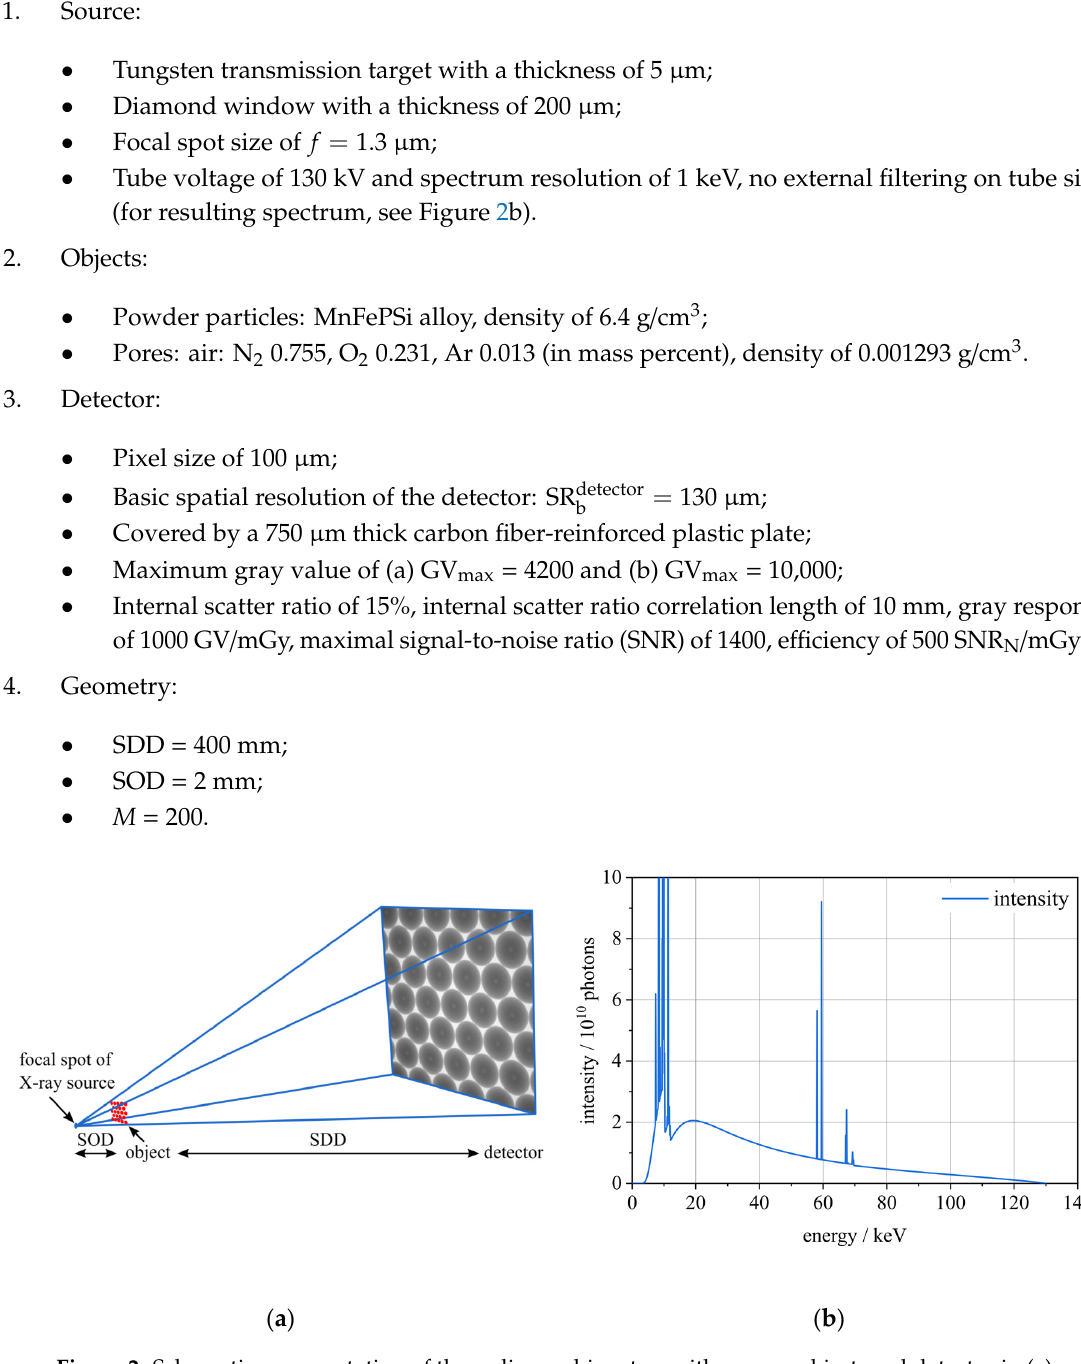
Figure 2. Schematic representation of the radiographic setup with source, object, and detector in ( a ), and the 130 kV spectrum plot used in the simulation in ( b ).